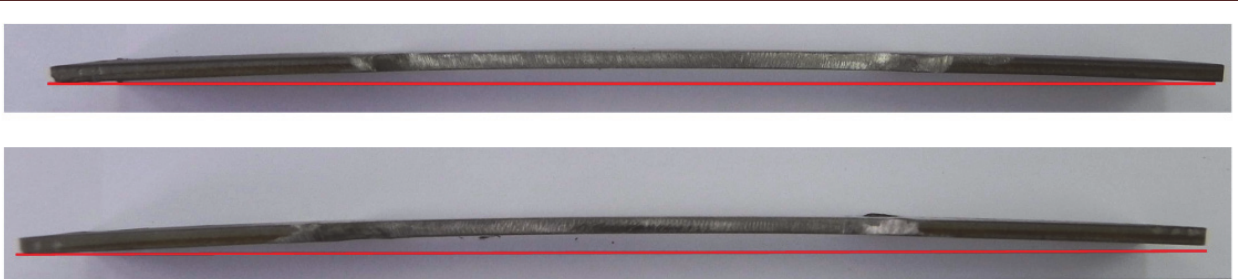
Figure 5: Deformation of samples caused by residual stress relaxation.